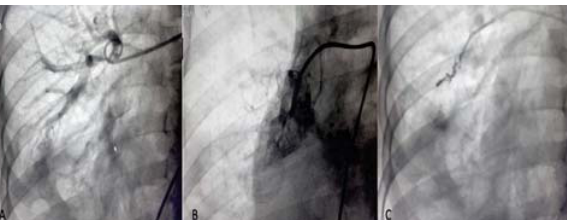
Figure 2. Right pulmonary artery angiogram (A) (cid:86)(cid:75)(cid:82)(cid:90)(cid:76)(cid:81)(cid:74)(cid:3)(cid:68)(cid:69)(cid:81)(cid:82)(cid:85)(cid:80)(cid:68)(cid:79)(cid:3)(cid:70)(cid:82)(cid:81)(cid:87)(cid:85)(cid:68)(cid:86)(cid:87)(cid:3)(cid:191)(cid:79)(cid:79)(cid:72)(cid:71)(cid:3)(cid:82)(cid:88)(cid:87)(cid:83)(cid:82)(cid:88)(cid:70)(cid:75)(cid:76)(cid:81)(cid:74)(cid:3)(cid:76)(cid:81)(cid:3)(cid:85)(cid:76)(cid:74)(cid:75)(cid:87)(cid:3) lower lung supplied by branch of right descending pulmonary artery. and shunting of pulmonary artery and vein (pulmonary arteriovenous malformation). Selective angiogram of right descending pulmonary after coil embolization (C) showing complete occlusion of the artery feeding the malformation